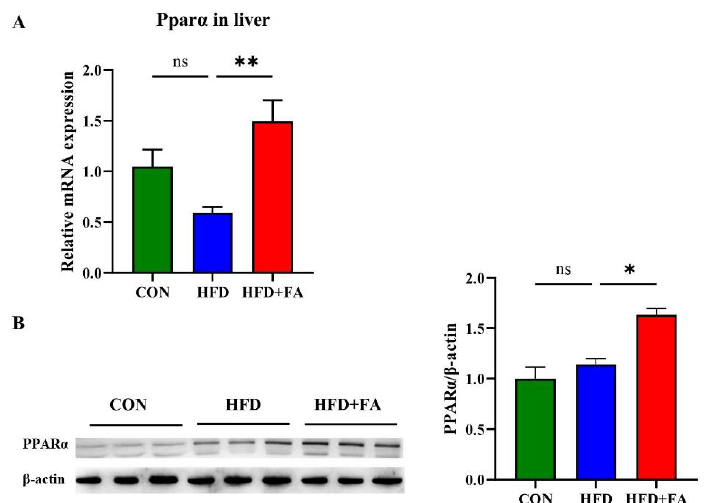
Figure 5. FA activates PPARα in liver. ( A ) The relative mRNA levels of Ppara ( n = 6); ( B ) Western blot analysis of hepatic PPAR α protein in the CON, HFD and HFD+FA mice ( n = 3). Data are shown as mean ± SEM. * p < 0.05, ** p < 0.01.